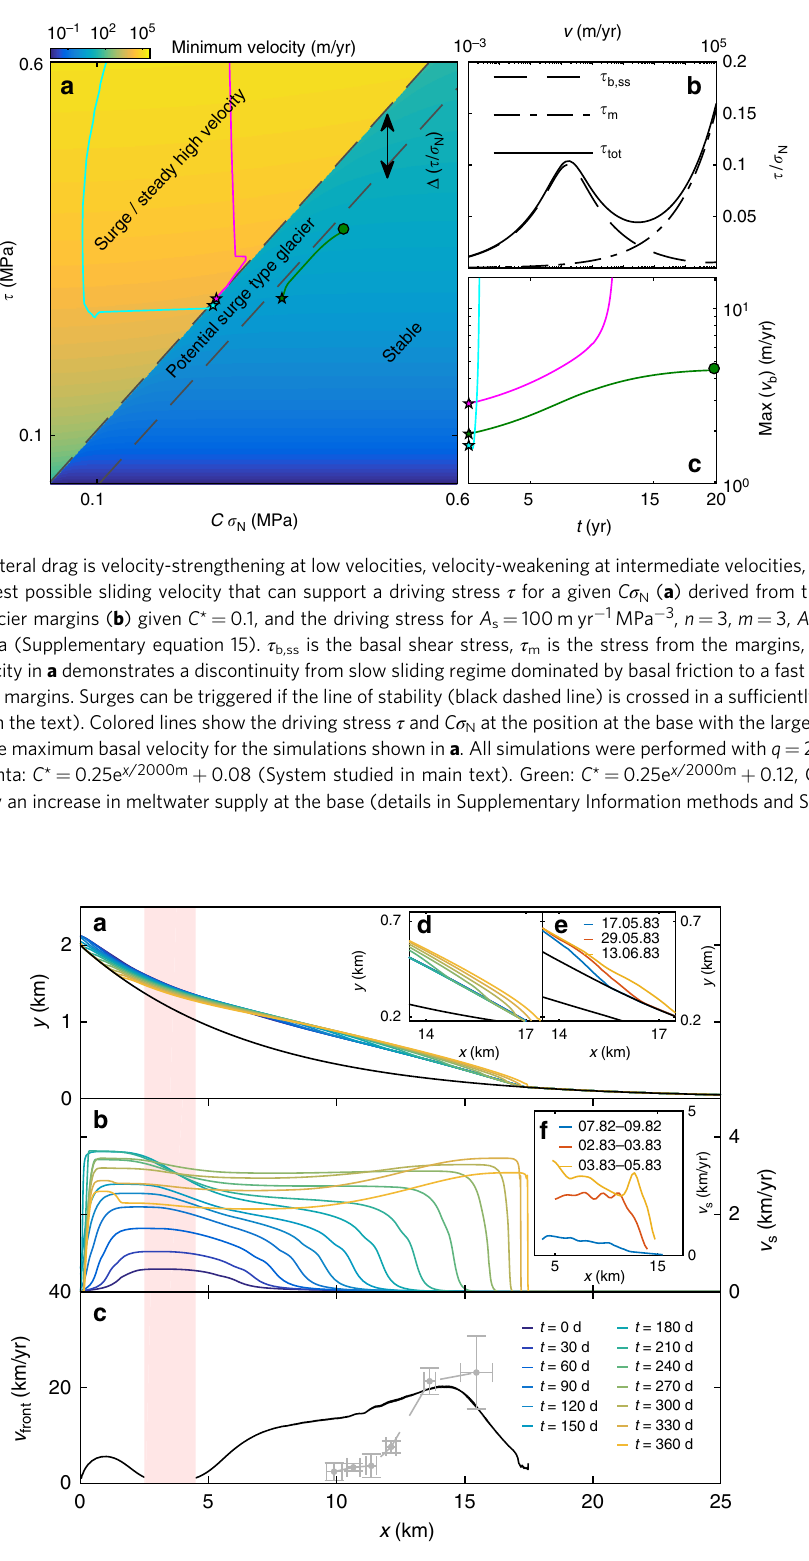
Fig. 5 Surge propagation in the model including qualitative comparison with the Variegated Glacier surge. a Evolution of the glacier geometry with time during a surge. d Detail of the simulated geometry. e Surge front of Variegated Glacier adapted from Kamb et al. 13 . b Evolution of surface velocities in time. f Variegated glacier velocities from Jay-Allemand 24 (the acceleration at the end of the surge is omitted). c Surge propagation speed as a function of front position downstream, dashed line shows surge propagation velocities from the Variegated Glacier. The red marker shows the trigger region. Simulation performed with d c = 1.0 m and q =